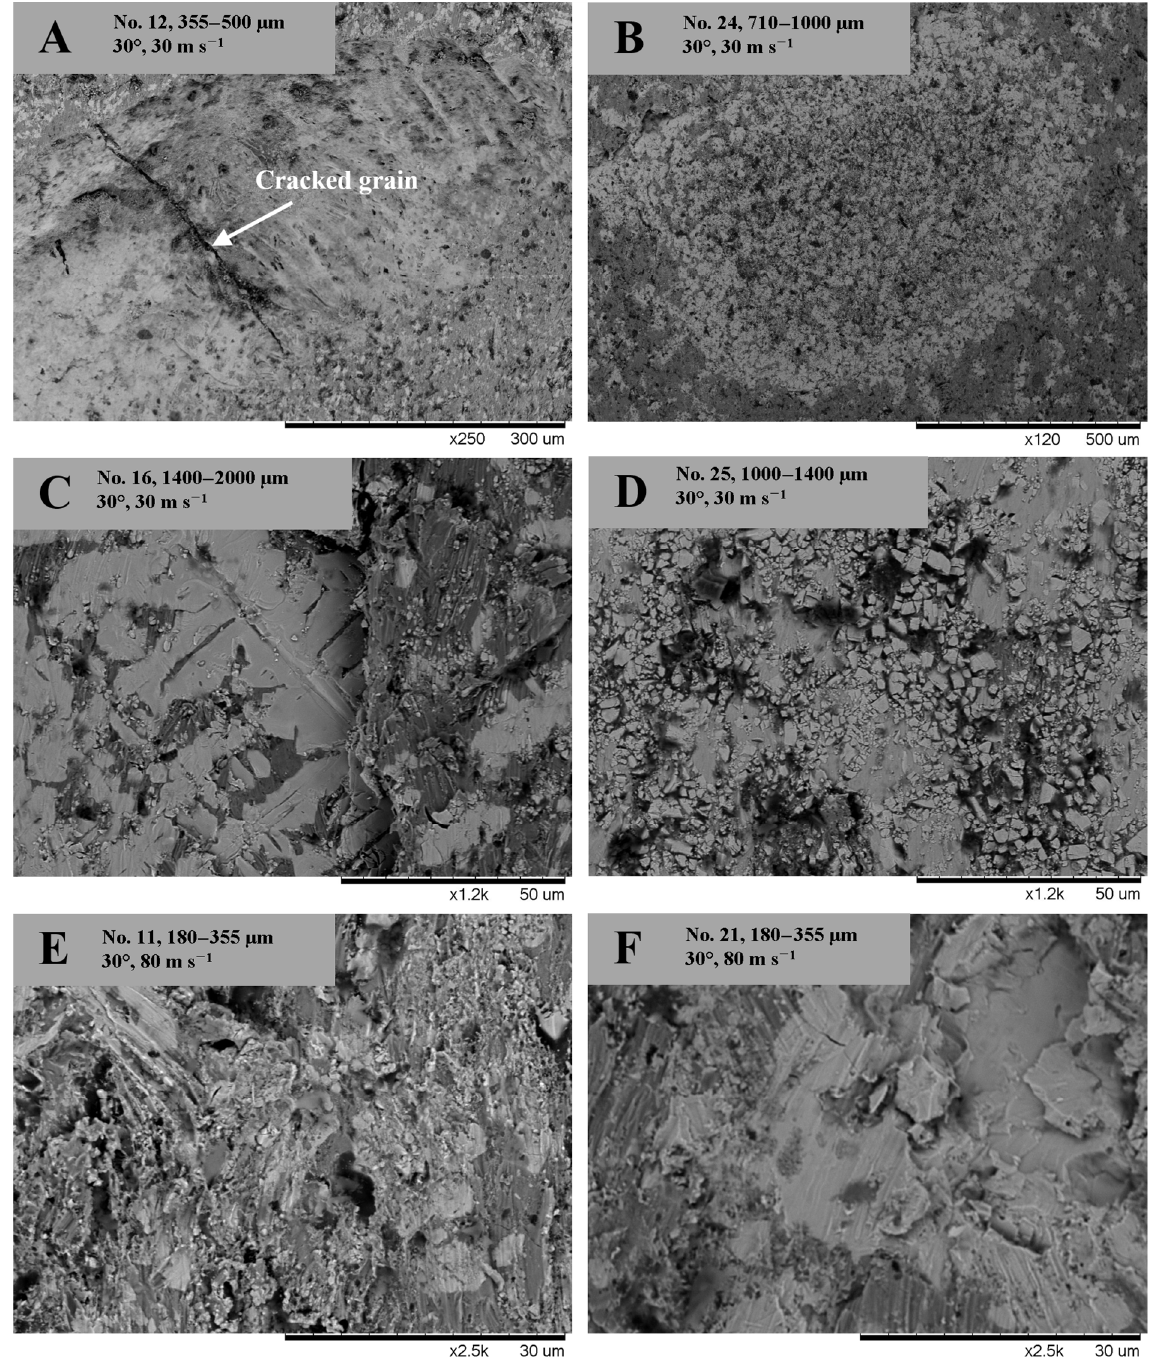
Figure 8. SEM images of the sample surfaces after erosive test at 30 ( A – D ) and 80 ( E , F ) m·s −1 particle velocity and 30° impact angle.